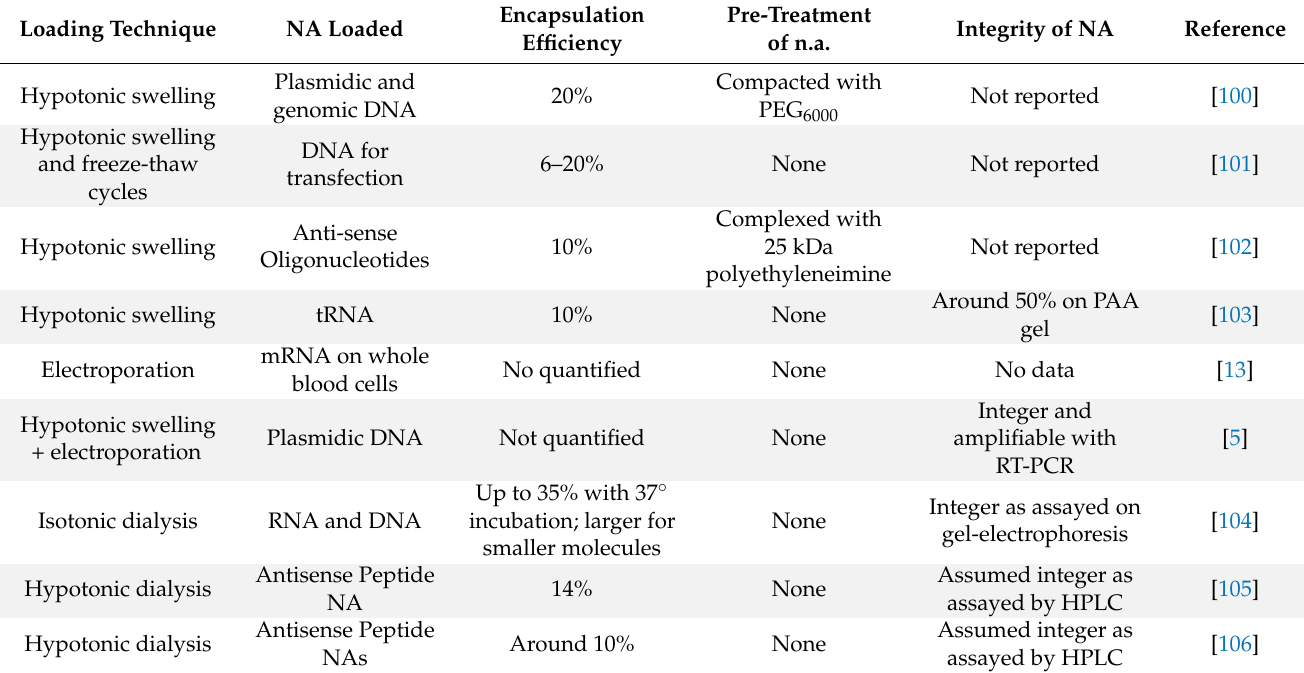
Table 1. Comparison of techniques and cases of erythrocytes loaded with